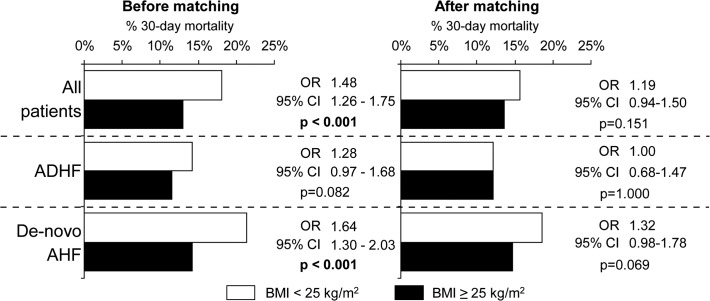
Thirty-day mortality according to the BMI category and type of heart failure.